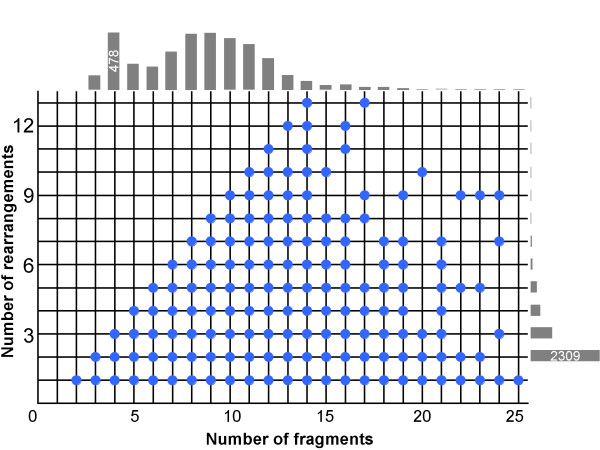
All possible complexities of fragment rearrangements in an alignment have been observed. The figure shows a scatter plot of the number of fragment rearrangements vs the number of fragments in the alignment. Bar charts on the top and on the right of the picture reflect the occurrence of alignments with a particular number of fragments and number of rearrangements. Only alignments with more that one fragment rearrangement have been considered to calculate the bar proportion. The numbers on the bars help visualize the scale. The area in the right-upper corner is not populated because of a lack of statistics (see text).